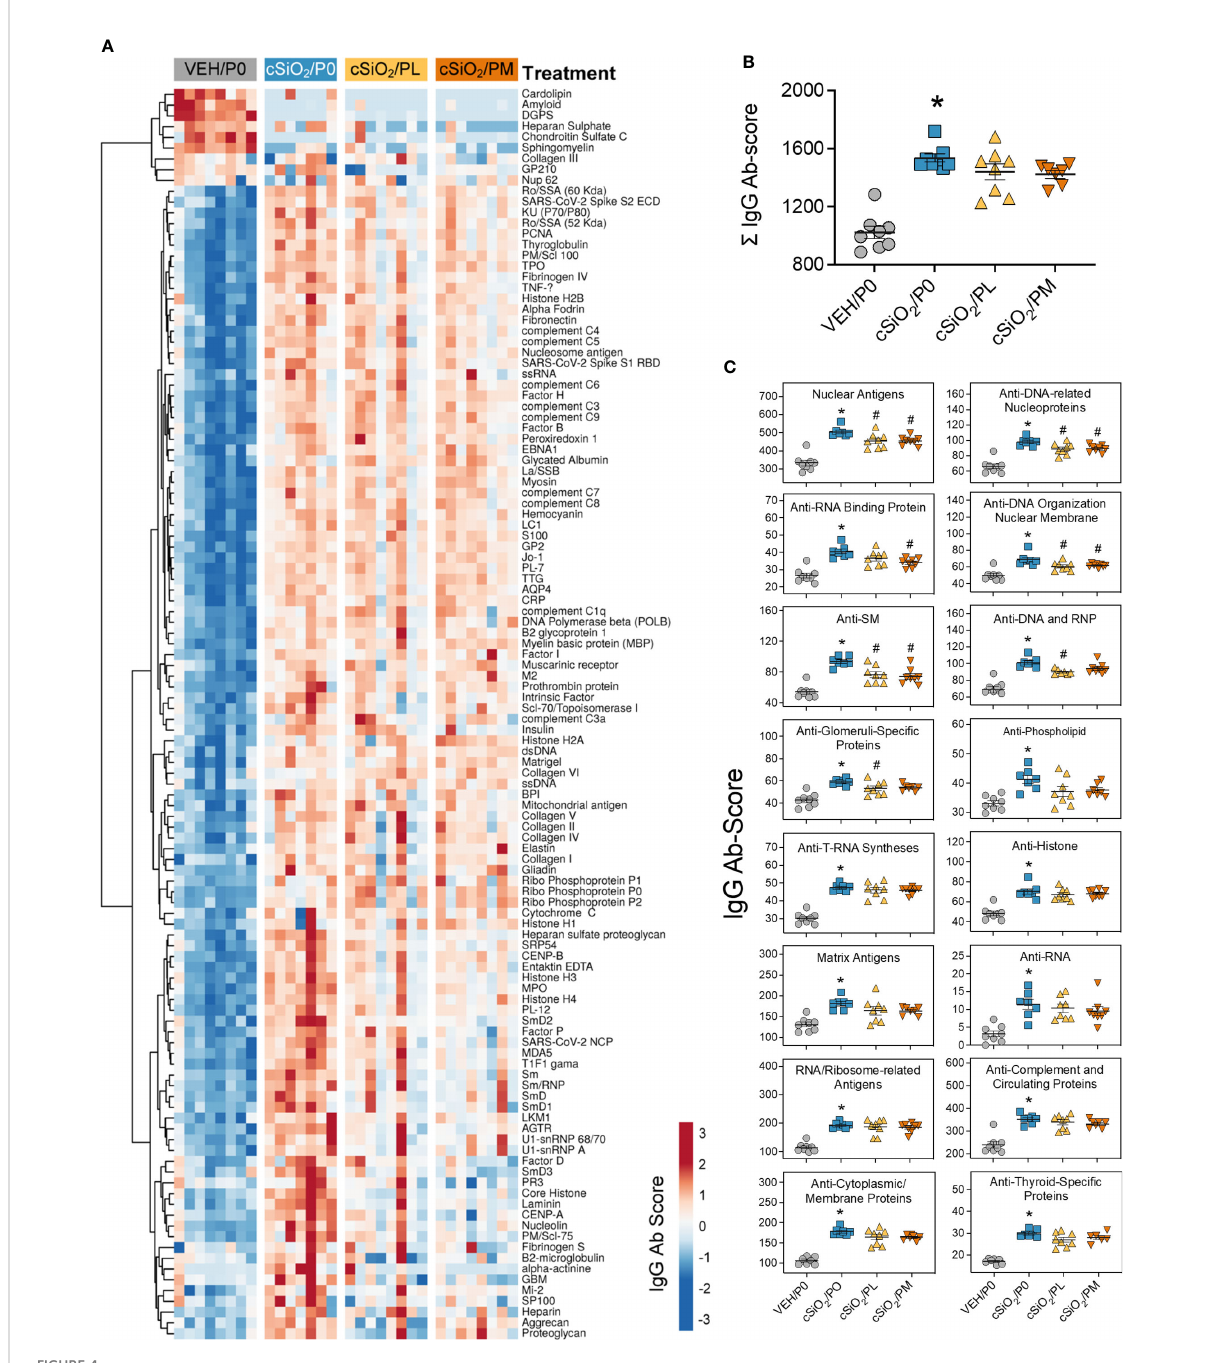
FIGURE 4 Prednisone treatment is effective in reducing a subset of cSiO 2 -induced AAbs in the BALF. AAbs production was measured in BALF using Cohort A samples collected at time of necropsy (14 wk PI). (A) Heat map illustrates unsupervised clustering (Euclidian distance method) of 122 AAbs shown as Ab-score values for IgG expression in BALF. Scale bar values re fl ect the range of variance-stabilized Ab scores, which were centered across rows. (B) Prednisone does not signi fi cantly reduce cSiO 2 -triggered increased total IgG levels in the BALF. (C) prednisone treatment was effective in signi fi cantly reducing certain classes of autoantibodies in the BALF compared to cSiO 2 /P0 positive control. *Indicates p<0.05 for VEH/P0 vs cSiO 2 /P0; # indicates p<0.05 for cSiO 2 /P0 vs cSiO 2 /PL or cSiO 2 /PM